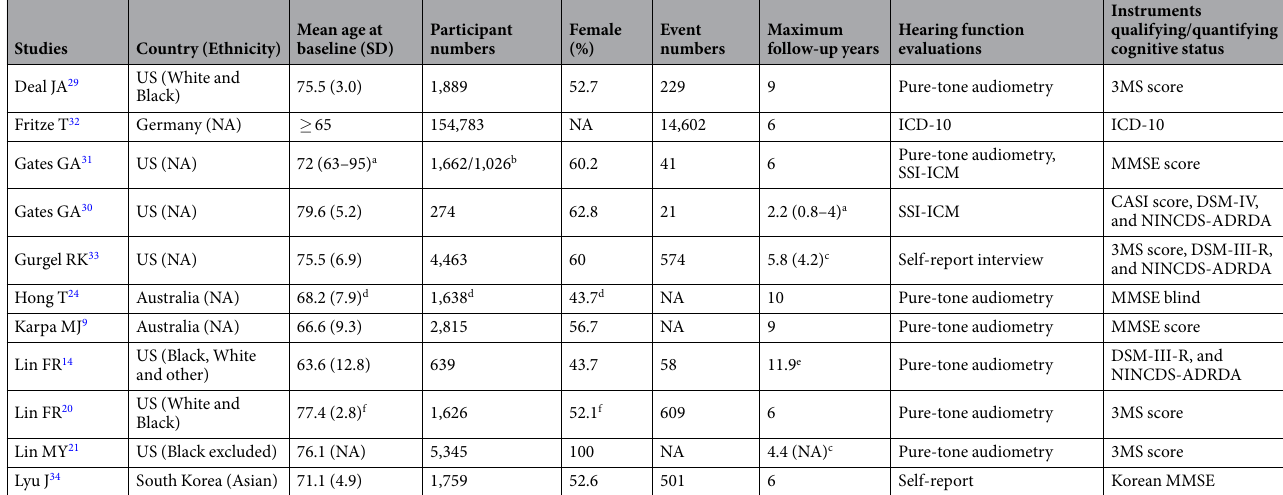
Table 1. Characteristics of included studies. Abbreviations: 3MS = Modified Mini-Mental State Examination, CASI = Cognitive Abilities Screening Instrument, DSM = Diagnostic and Statistical Manual, ICD = International Classification of Diseases, MMSE = Mini-Mental State Examination, NA = not available, NINCDS-ADRDA = National Institute of Neurological and Communicative Disorders and Stroke and the Alzheimer’s Disease and Related Disorders Association, SD = standard deviation, SSI-ICM = Synthetic Sentence Identification with Ipsilateral Competing Message, UK = United Kingdom, US = United States. a Mean (range),